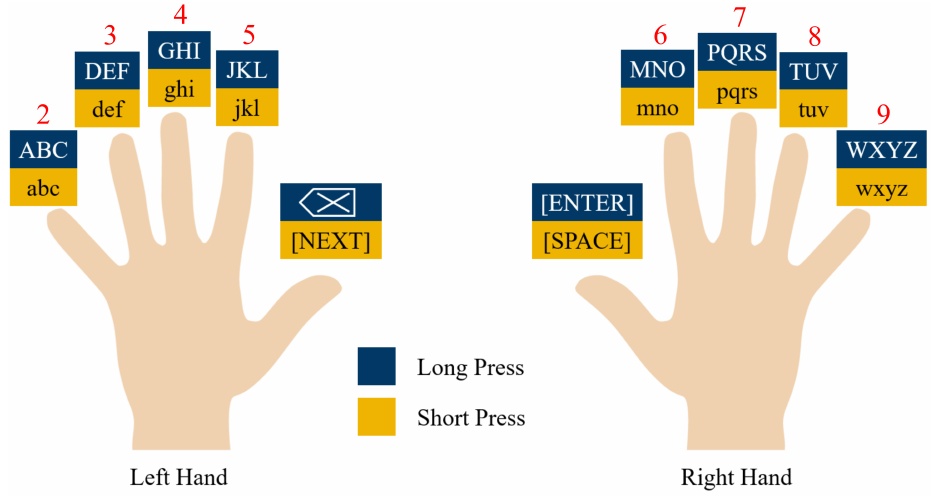
Figure 6. Keyboard layout showing the letter and function distribution for each finger. Secondary functionalities are in the blue boxes and can be accessed by long button presses. The red digits represent the underlying code for each button that are used to generate word